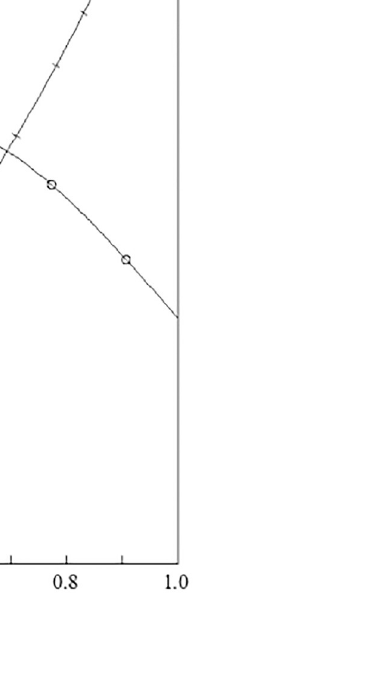
Fig 6. The relationship between q and β